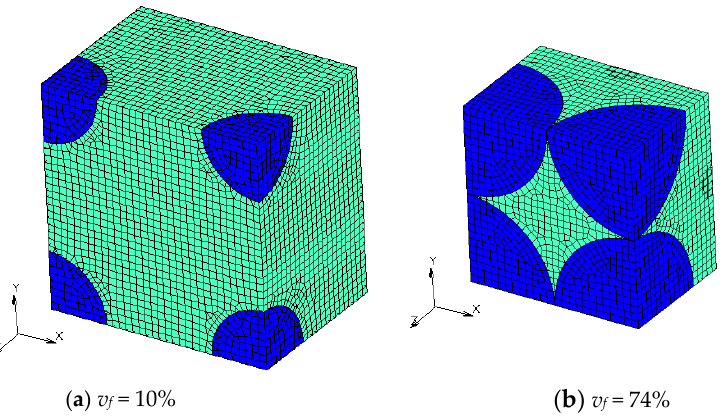
Figure 4. Numerical models of FCC microstructures with different volume fractions v f .